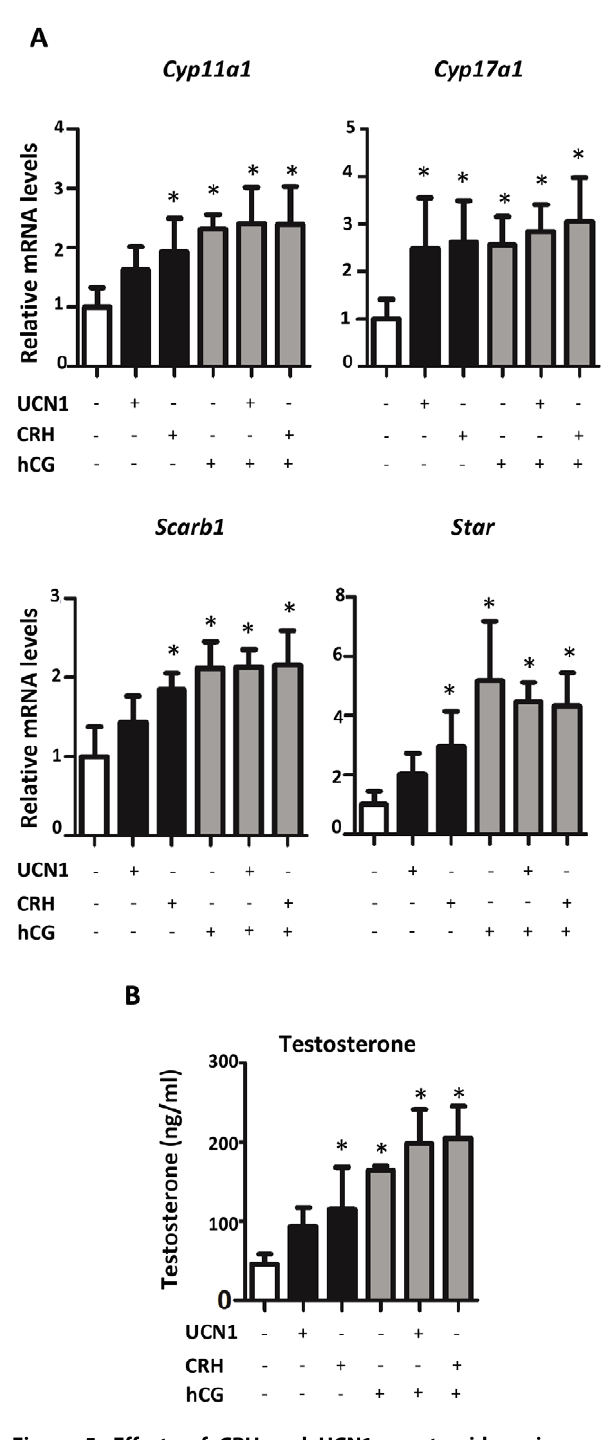
Figure 5. Effects of CRH and UCN1 on steroidogenic gene expression in GD19 rat testis. A) Steroidogenic gene expression in GD19 rat testis after exposure to 1 nM CRH, 1 nM UCN1, and/or 0.1 IU/ ml hCG. Testes were exposed for 24 hours, and mRNA levels were determined using Taqman-based qRT-PCR. Mean 6 SD are shown for all data. Four to five samples per group. Asterisk indicates significance for p-value of , 0.05 when compared with controls. B) Testosterone levels in GD19 rat testis after exposure in vitro to 1 nM CRH, 1 nM UCN1, and/ or 0.1 IU/ml hCG. Testes were exposed for 24 hours and media collected from four to five samples/group for testosterone measure- ment. Mean 6 SD shown for all data. Asterisk indicates significance for p-value of , 0.05 when compared with vehicle